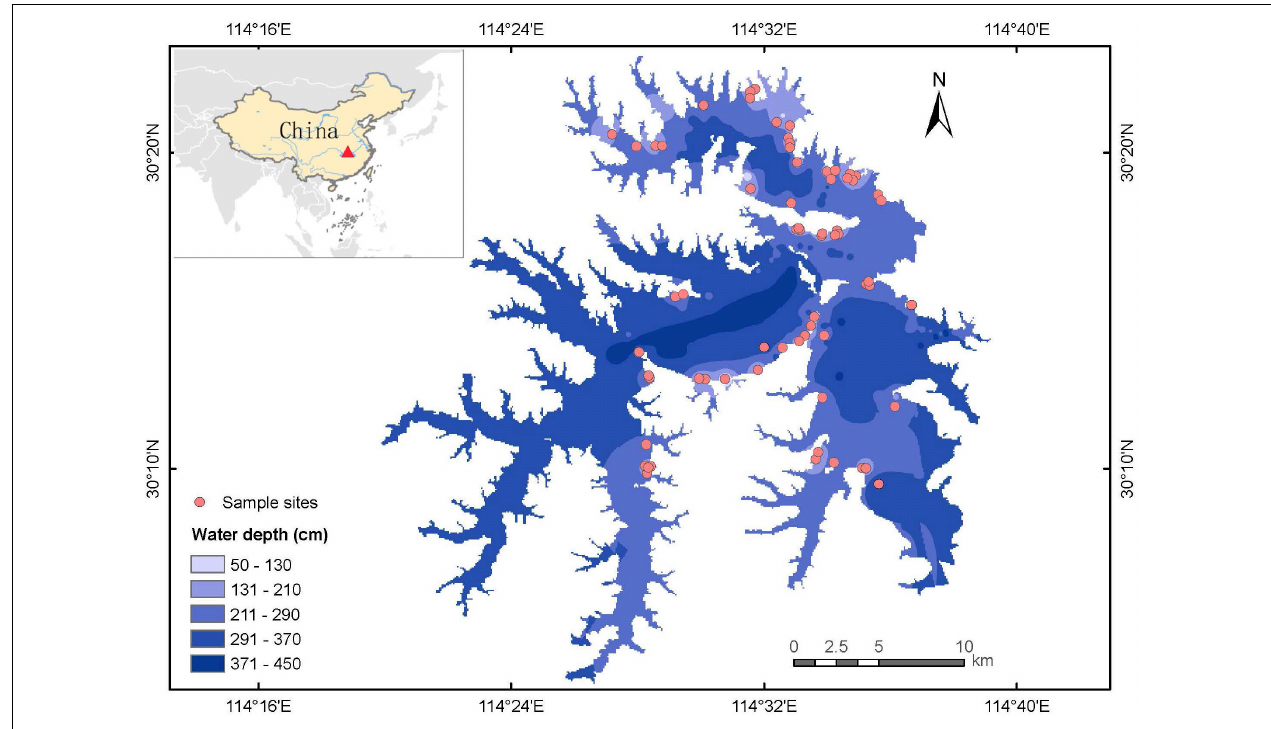
FIGURE 1 | Map of Liangzi Lake. The red dots represent the locations of sampling sites.